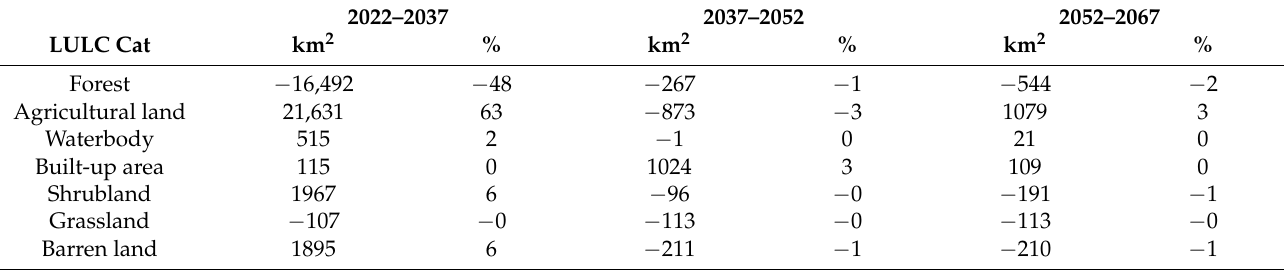
Table 11. LULC changes from 2037 to